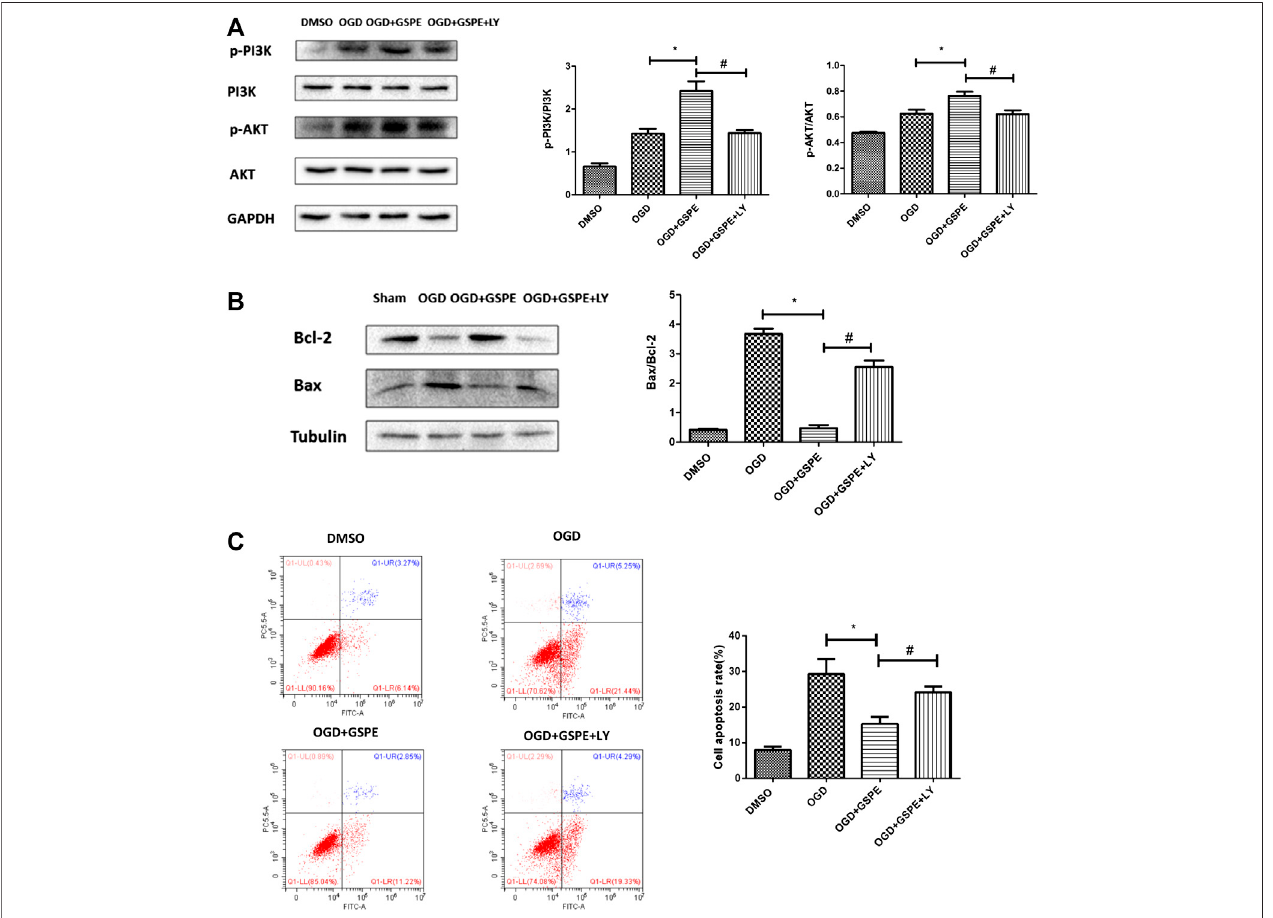
FIGURE7| InhibitionofPI3K/AKTpathwayreversedtheprotectiveeffectofGSPEonH9C2cells. (A) EffectsofGSPEtreatmentontheH9C2cellsofp-PI3K,PI3K, p-AKT and AKT evaluated by Western blot analysis. (B) Effects of GSPE on the expression of Bax and Bcl-2 evaluated by Western blot analysis. (C) H9C2 cells in different treatment were stained by Annexin V-FITC/PI staining and then distinguished by fl ow cytometer. Then cell apoptosis rate was quanti fi ed. *Signi fi cant difference compared with the OGD group, p < 0.05; #signi fi cant difference compared with the OGD + GSPE group, p < 0.05. p (cid:2) 3 per group.